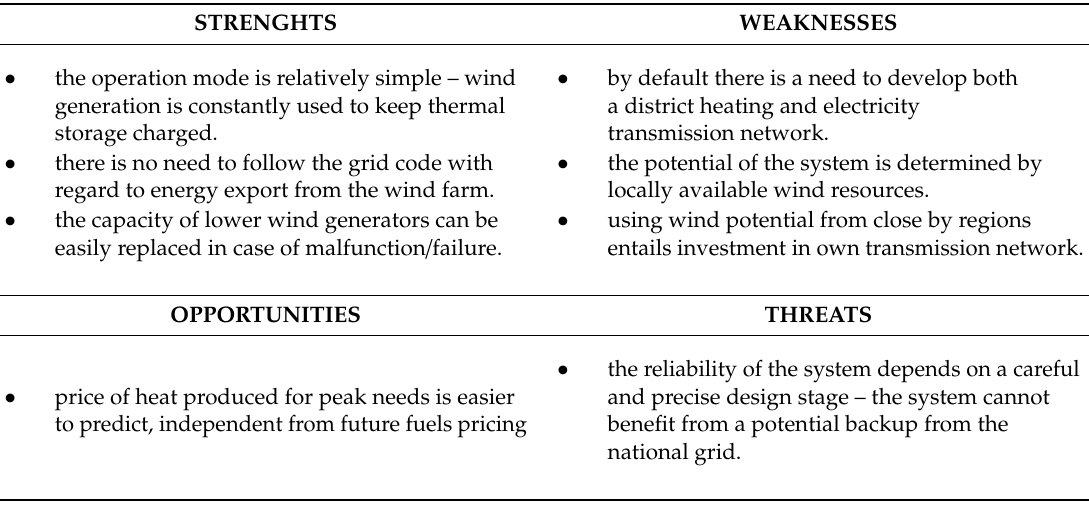
Table 1. SWOT (Strengths, Weaknesses, Opportunities and Threats) analysis on the potential of o ff -grid wind-geo district heating system development.